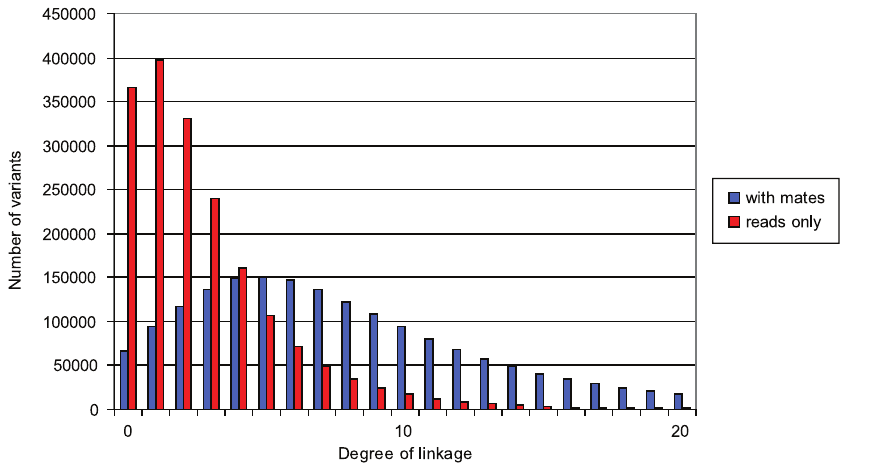
Figure 11. Degree of Linkage of Heterozygous Variants The distribution of the number of other variants to which a given variant can be linked using sequencing reads only or using mated reads as well is shown. Linkage of variants based on individual sequencing reads is limited, regardless of sequence coverage beyond a modest level, but is substantially increased by the incorporation of mate pairing information. The size of the effect is considerably more than simply doubling read length, due to variation in insert size; consequently, benefits of increasing sequencing coverage drop off much more